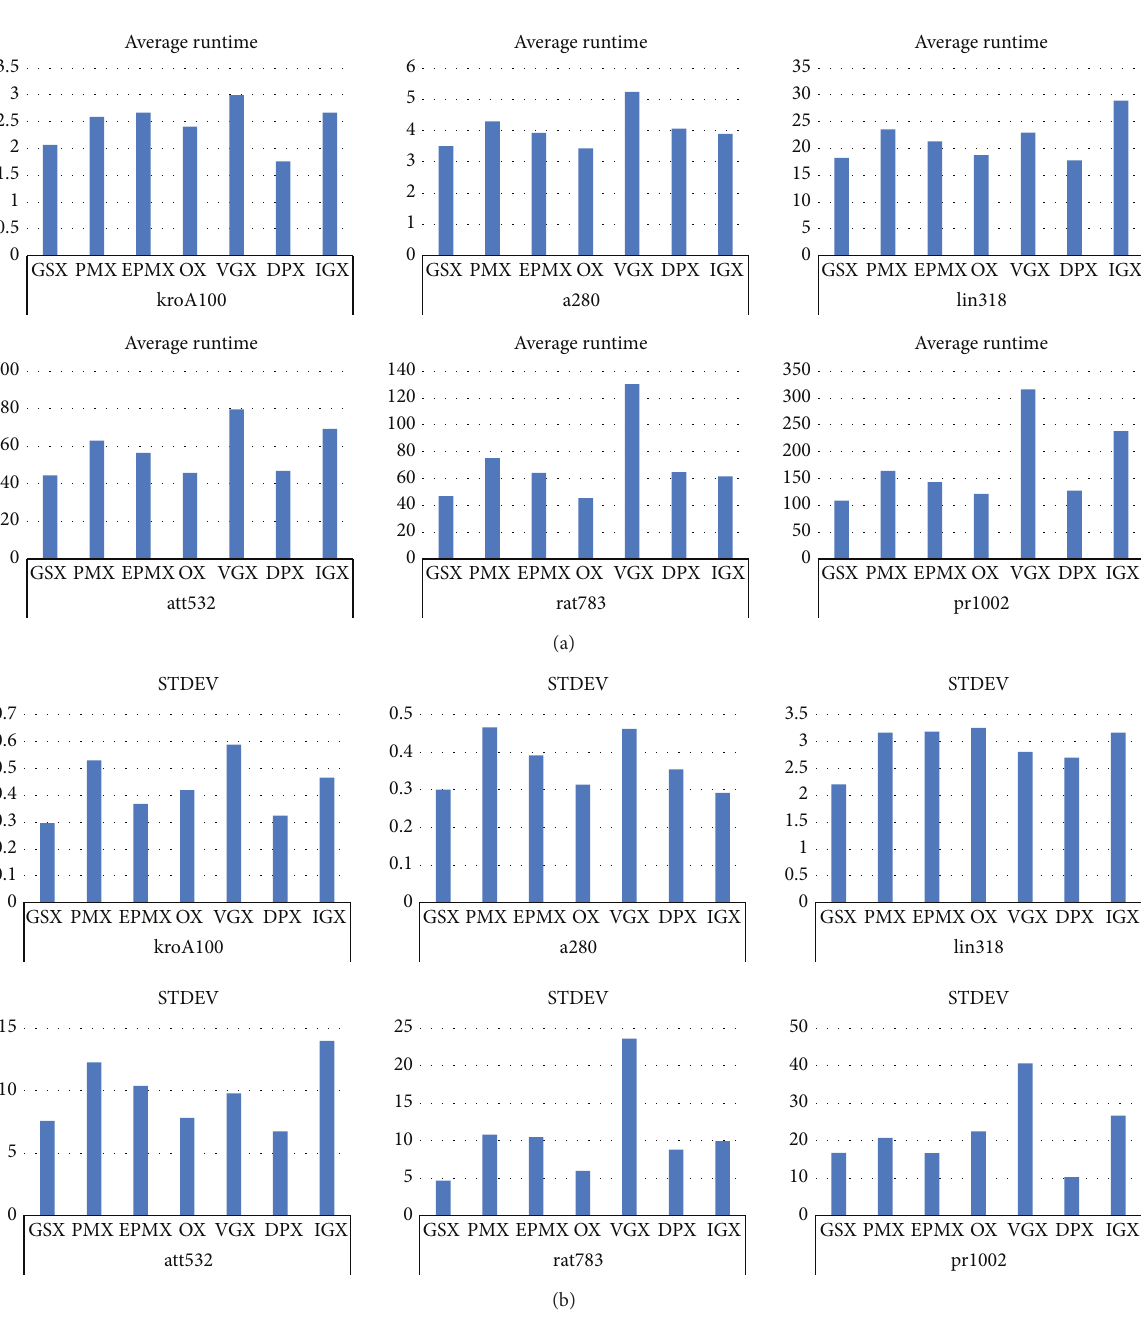
Figure 7: (a) Average required runtime and (b) STDEV of required